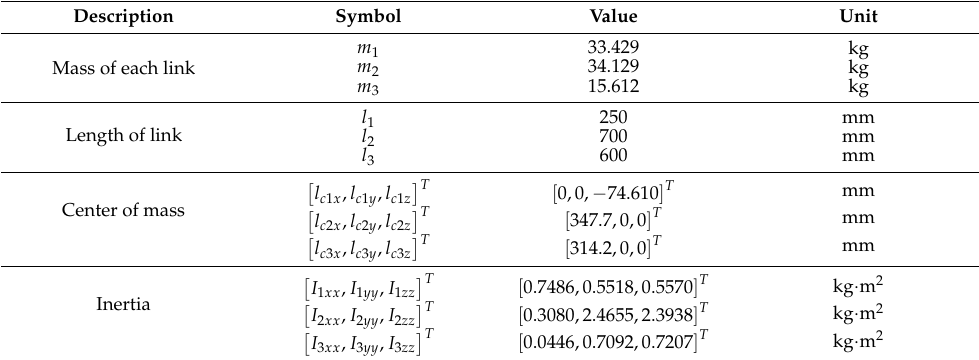
Table 2. The detailed design parameters of the robot.